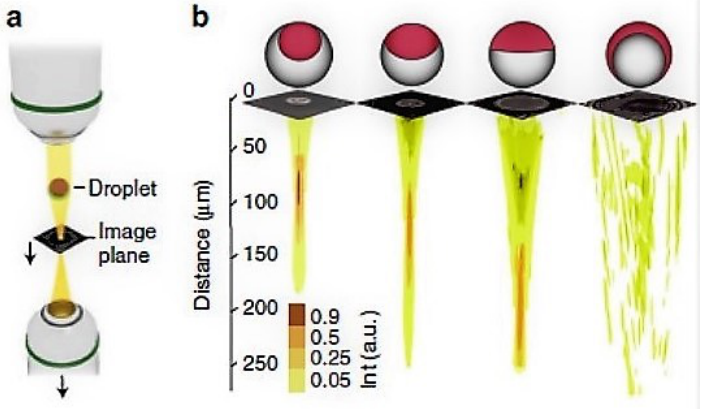
Figure 8. Imaging using microdroplets: setup for light input from the top with an adjustable image plane, droplets on a substrate, image plane, and bottom collection objective with vertical translation, characteristic focal length tunability based on the morphology of the emulsion, and corresponding fully converging-to-fully diverging mechanism. Reproduced with permission from